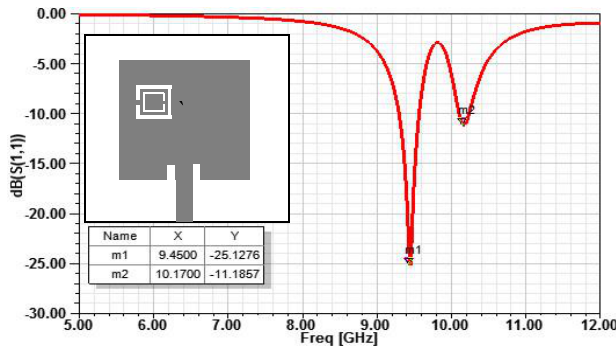
Figure 5: Dual-band antenna with single CSRR cell.